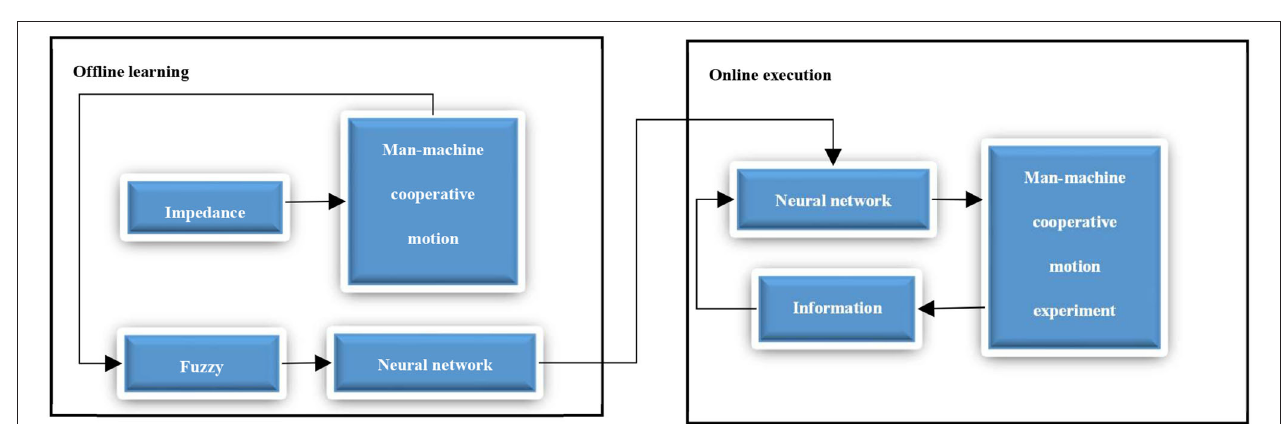
FIGURE 3 | Schematic diagram of operator intention recognition under machine learning.